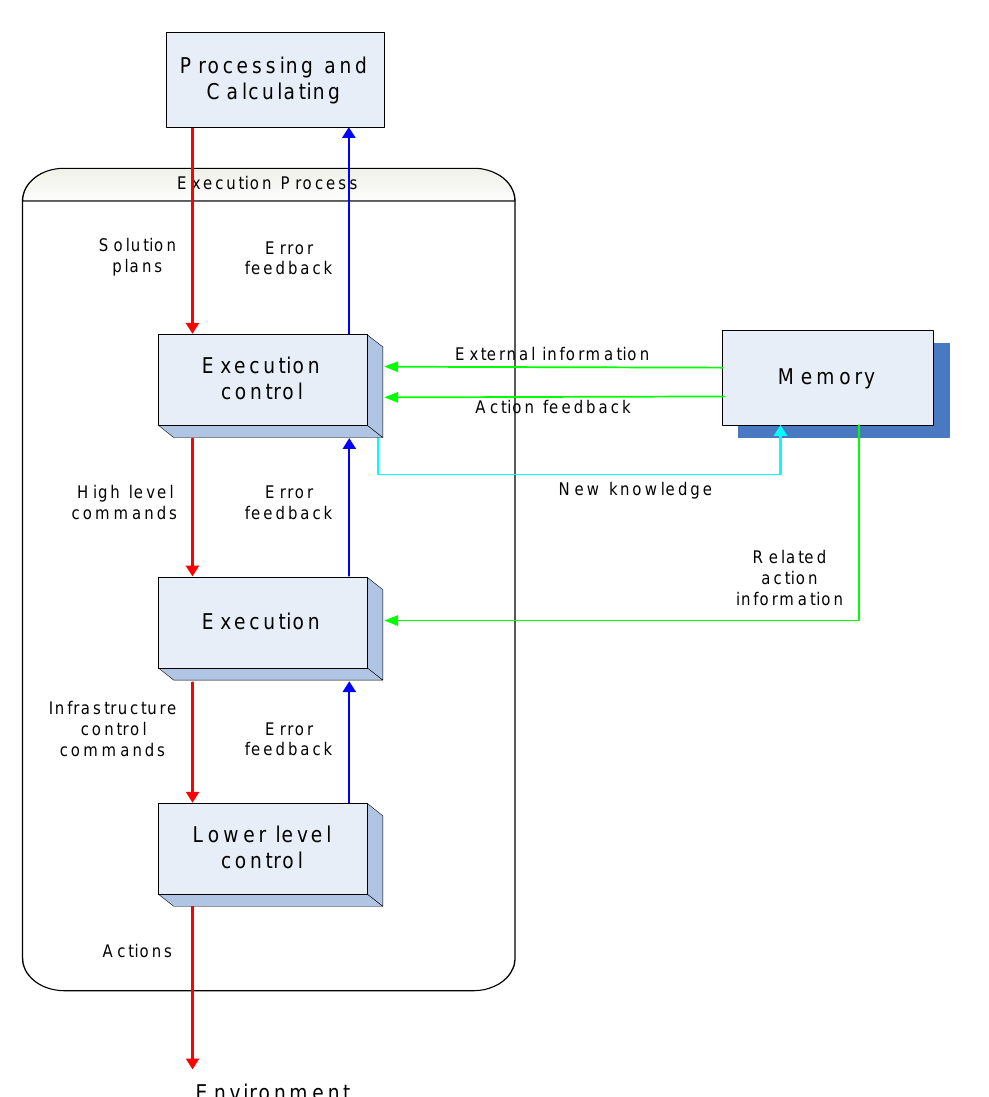
Figure 3. Execution Object within an autonomous